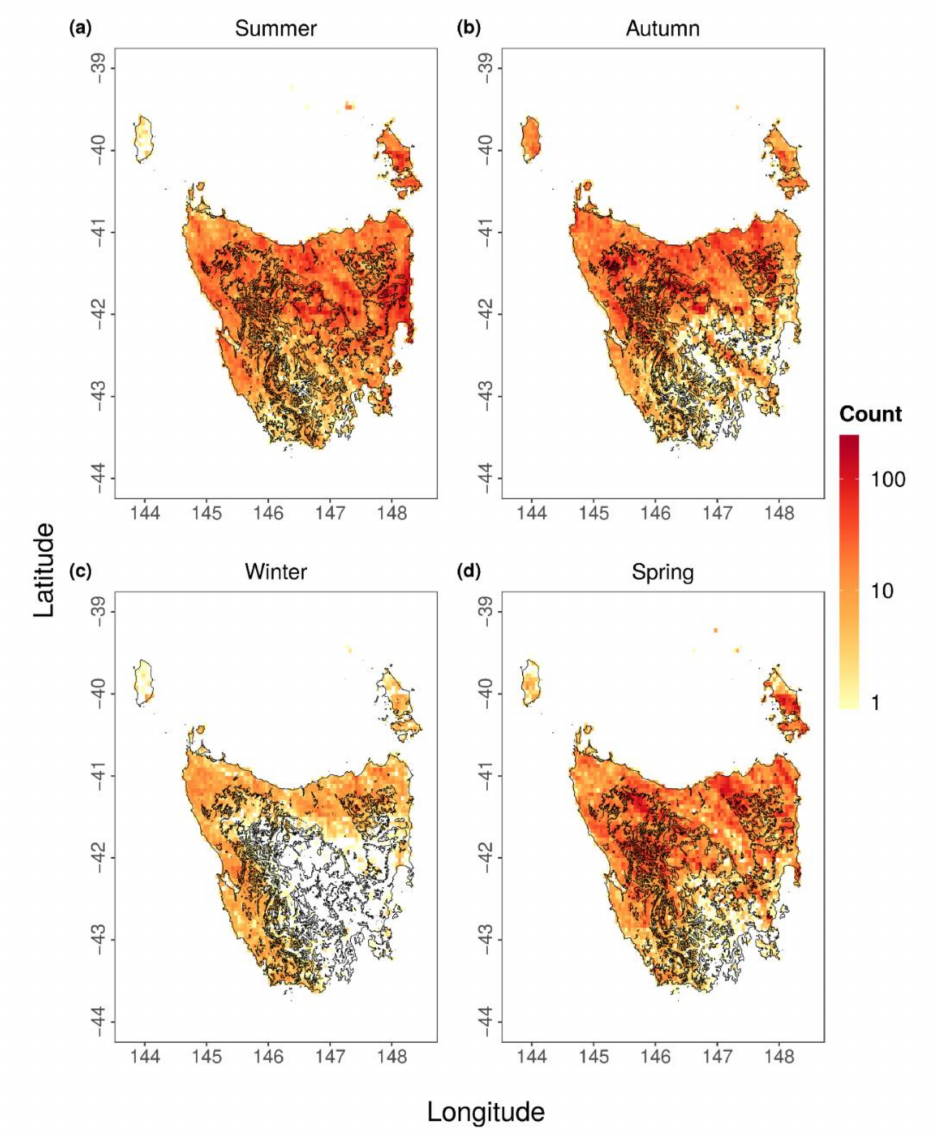
Figure 2. Seasonal count of cloud-to-ground (CG) lightning strikes (January 2011–June 2019), visualized by 5 km × 5 km rectangular binning: ( a ) summer, ( b ) autumn, ( c ) winter, ( d ) spring. The most critical fire season in Tasmania aligns with the summer months (December, January,